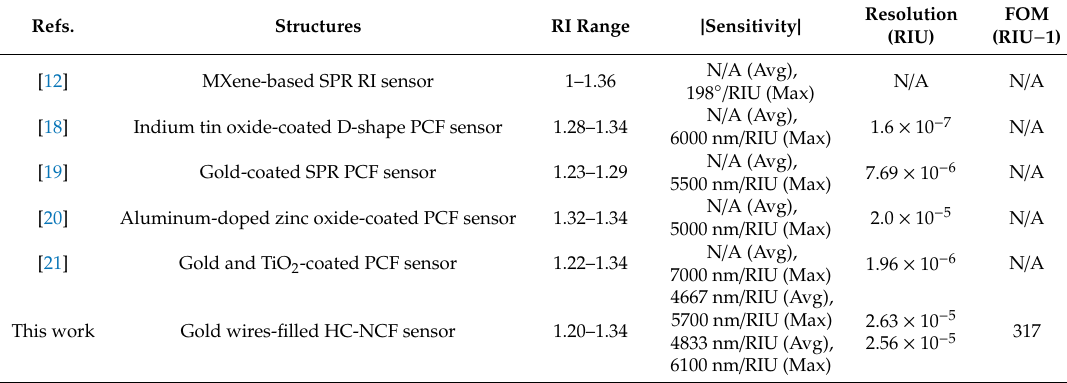
Figure 9. ( a ) The changes of the sensitivity and FOM with the RI of the filled analyte by the confinement loss method, ( b ) the changes of the sensitivity and maximum birefringence with the RI of the filled analyte by the birefringence analysis method, and ( c ) the change of the resolution with the RI of the filled analyte by the confinement loss method and birefringence analysis method, respectively. Table 2. Comparison results of the low RI sensing performances of the proposed gold wires-filled HC-NCF sensor with other works.